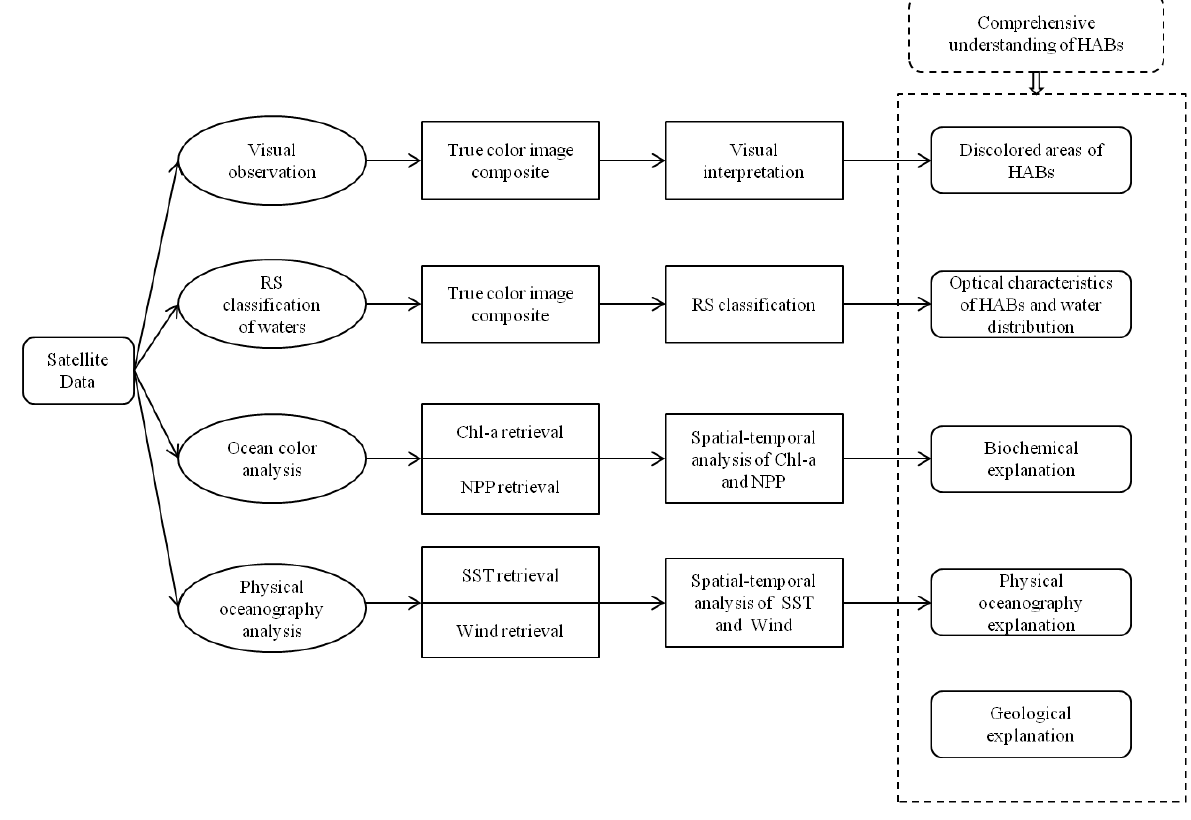
Figure 2. A synthesized framework of satellite remote sensing for detecting